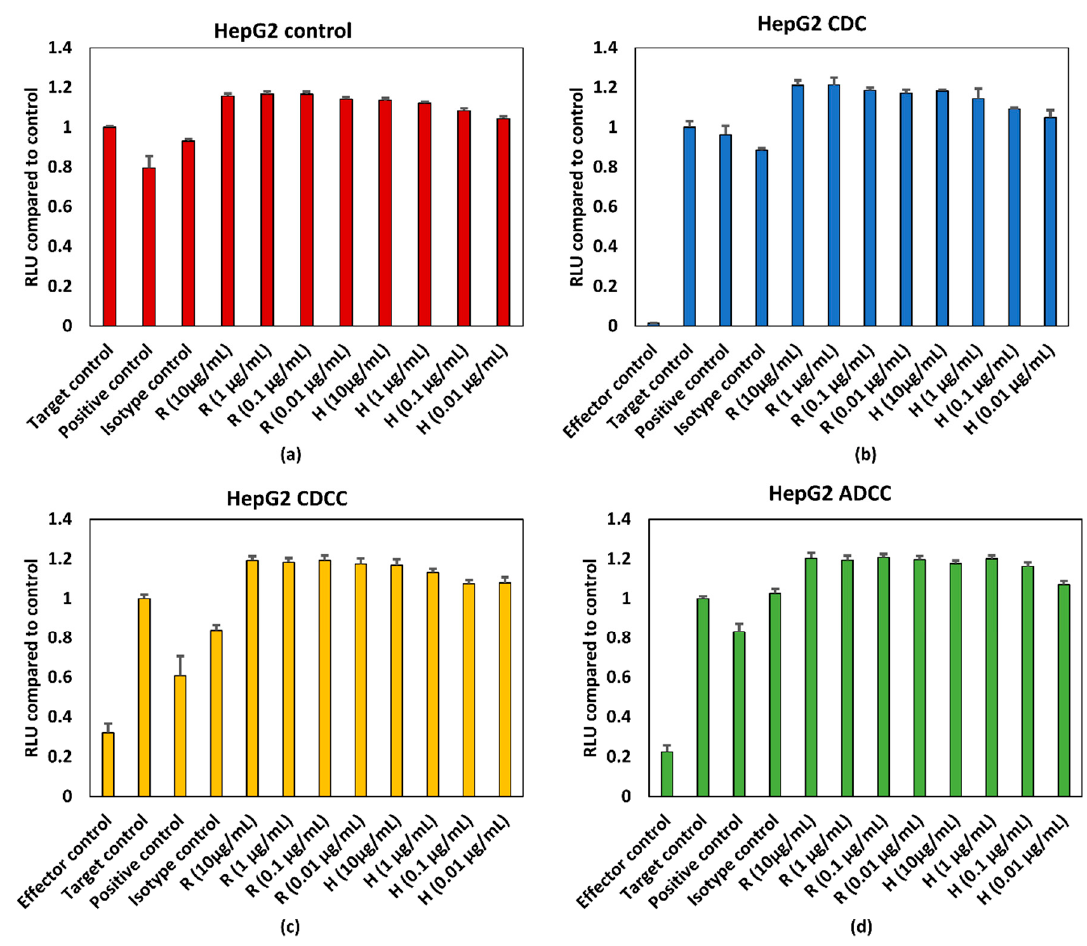
Figure 3. ( a ) Control conditions without effector cells/serum, ( b ) CDC, ( c ) CDCC, and ( d ) ADCC assay results of rituximab and trastuzumab based on the ATP content compared to control in HepG2 cells exposed to mAbs. Results represent pooled responses from four donors ( n = 4). All values expressed as relative luminescence units (RLU) compared to control (mean ± SE). R: Rituximab and H: Trastuzumab. Positive control is 5% ( v / v ) of absolute ethanol.